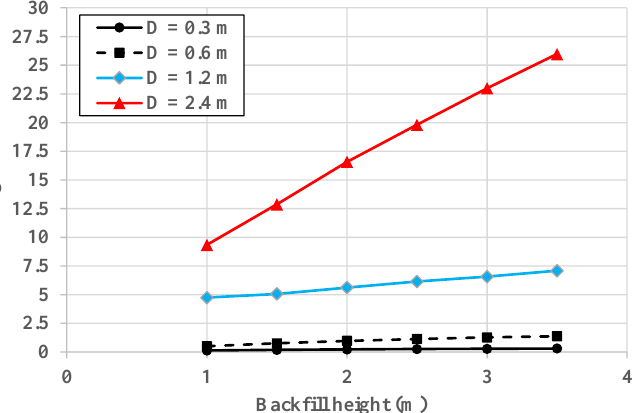
Figure 12. Effect of the pipe diameter and backfill height on the maximum pipe wall bending moment for the TDA 1.